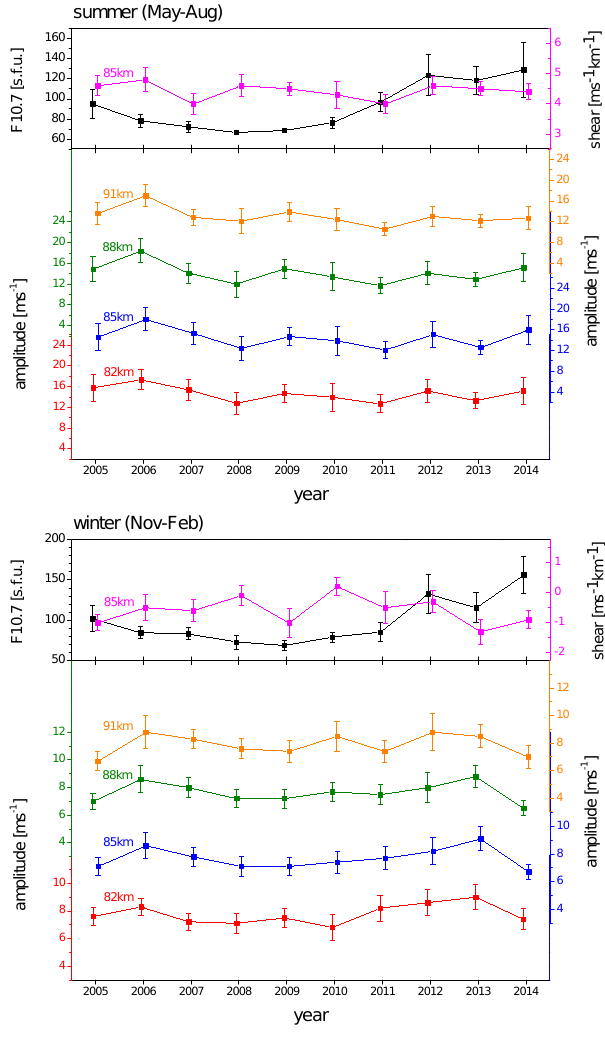
Figure 10. Seasonal mean QTDW total amplitudes for summer (May–August, upper panel) and winter (November–February, lower panel, the year refers to the one of the respective January) for dif- ferent altitudes in orange, green, blue and red. Error bars denote the standard error given by the standard deviation of the 11-day anal- yses during one season divided by the square root of independent samples (11 per season). Seasonal mean F10 . 7 solar radio fluxes and their standard deviations given in solar flux units (sfu) where 1sfu = 10 − 22 Wm − 2 Hz − 1 (black) and zonal wind shear of the pre- vailing wind at 85km and their standard errors (pink) are added.